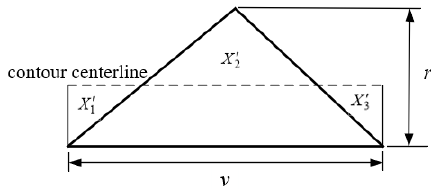
Figure 7. SRPF-LB model schematic.